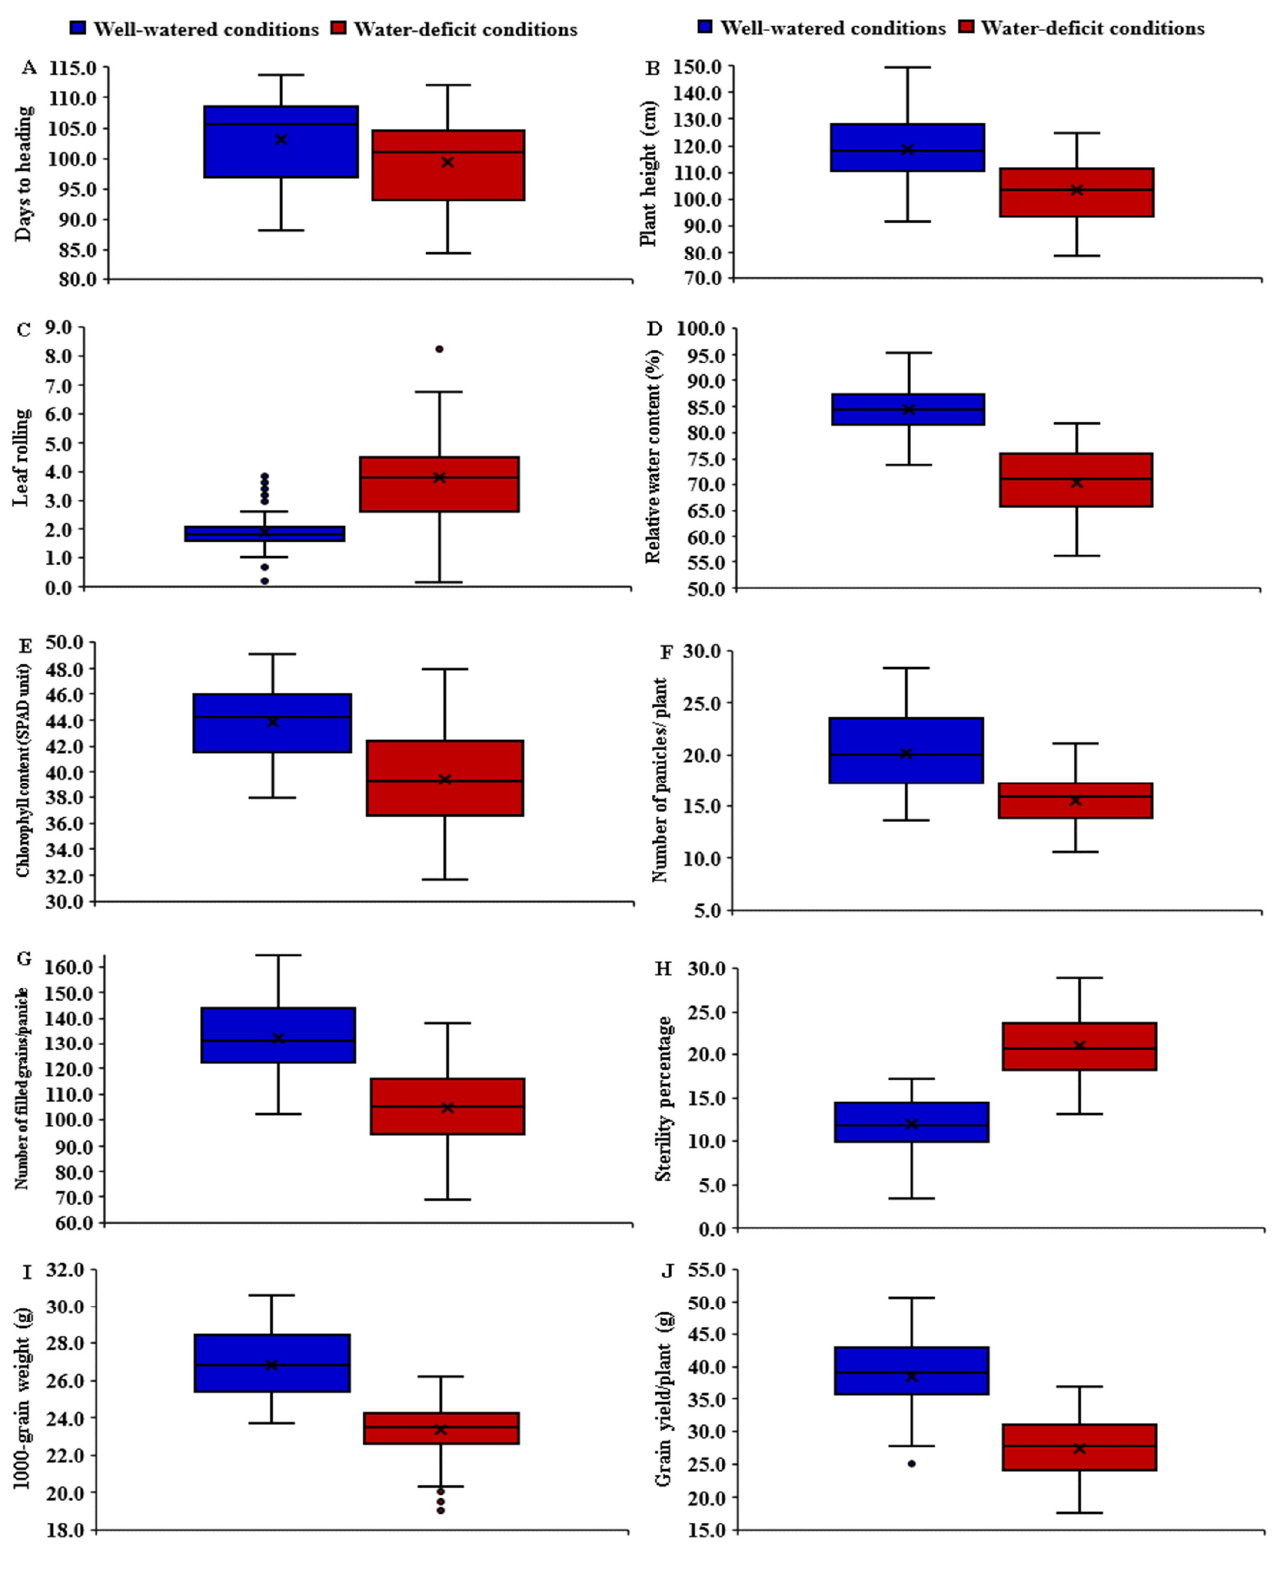
Figure 1. Boxplots for days to heading ( A ), plant height ( B ), leaf rolling ( C ), relative water content ( D ), chlorophyll content ( E ), number of panicles/plant ( F ), number of filled grains per panicle ( G ), sterility % ( H ), 1000-grain weight ( I ), and grain yield per plant ( J ) under well-watered and water-deficit conditions.